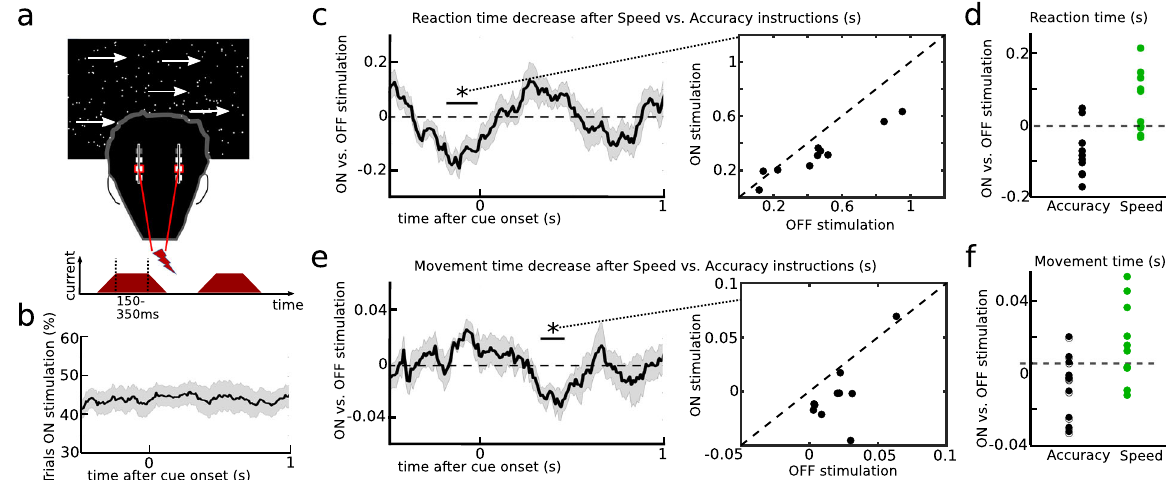
Fig. 4 | Behavioral effects of bilateral burst stimulation. a Bursts were given at random time points throughout the experiment. B This resulted in stimulation occurring on ~50% of trials for any 100ms moving time window. C Stimulation impaired patients ’ ability to adjust reaction times in a time window con fi ned to 180 – 10ms precue (DBS RT ), which is marked by an ‘ * ’ (corrected for multiple com- parisons using cluster-based permutation tests and two-sided alpha-level of 0.05). Single-subject responses ( n =10) to DBS RT are shown in the panel to the right. D DBS RT effects shown for each participant ( n =10) separately for accuracy(black)